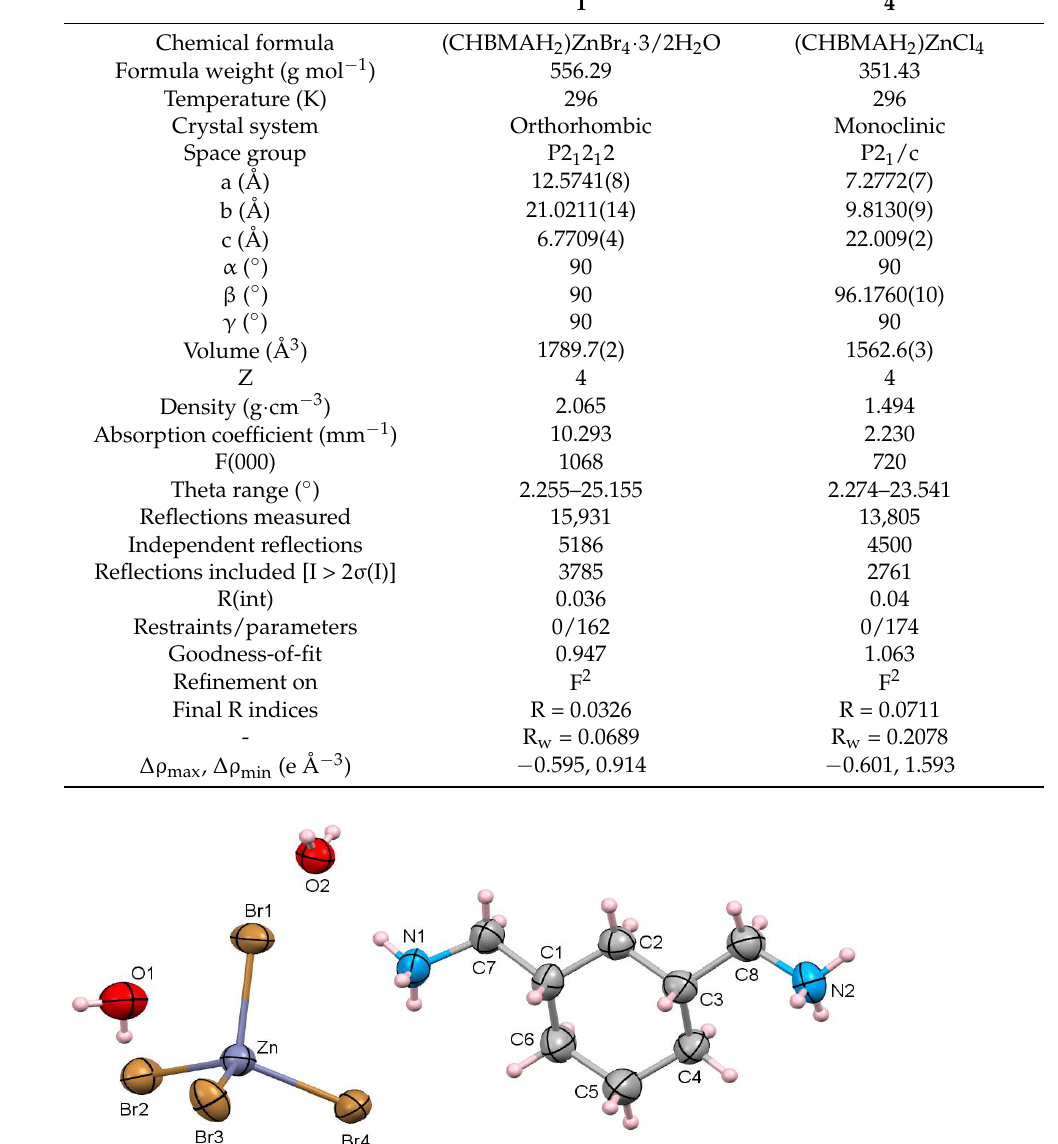
Figure 1. The asymmetric unit of (CHBMAH 2 )ZnBr 4 ·3/2H 2 O 1 (50% probability displacement el- lipsoids).